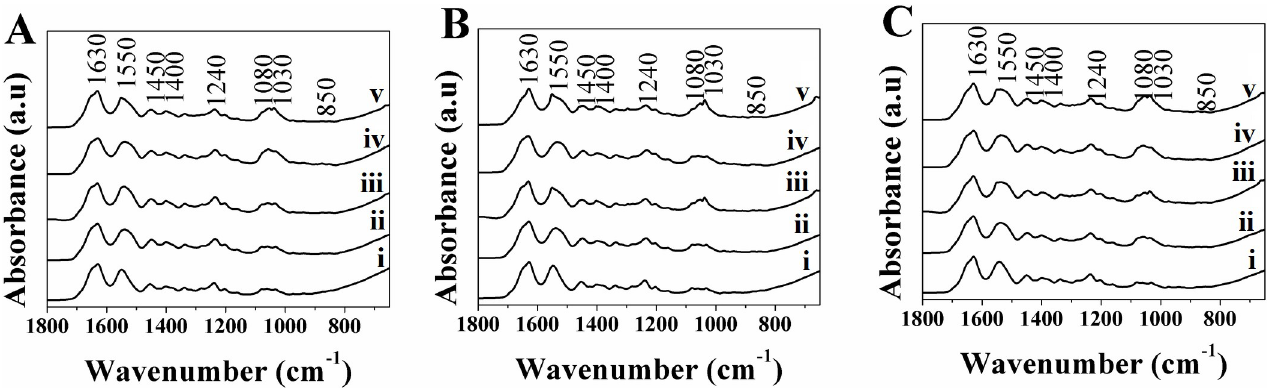
Fig 6. ATR-FTIR Spectra for A) DC, B) 1:10 DC-C s and C) 1:10 DC-C p , gels immersed in SBF at day i) 0, ii) 3, c) 7, iii) 10 and iv) 14.